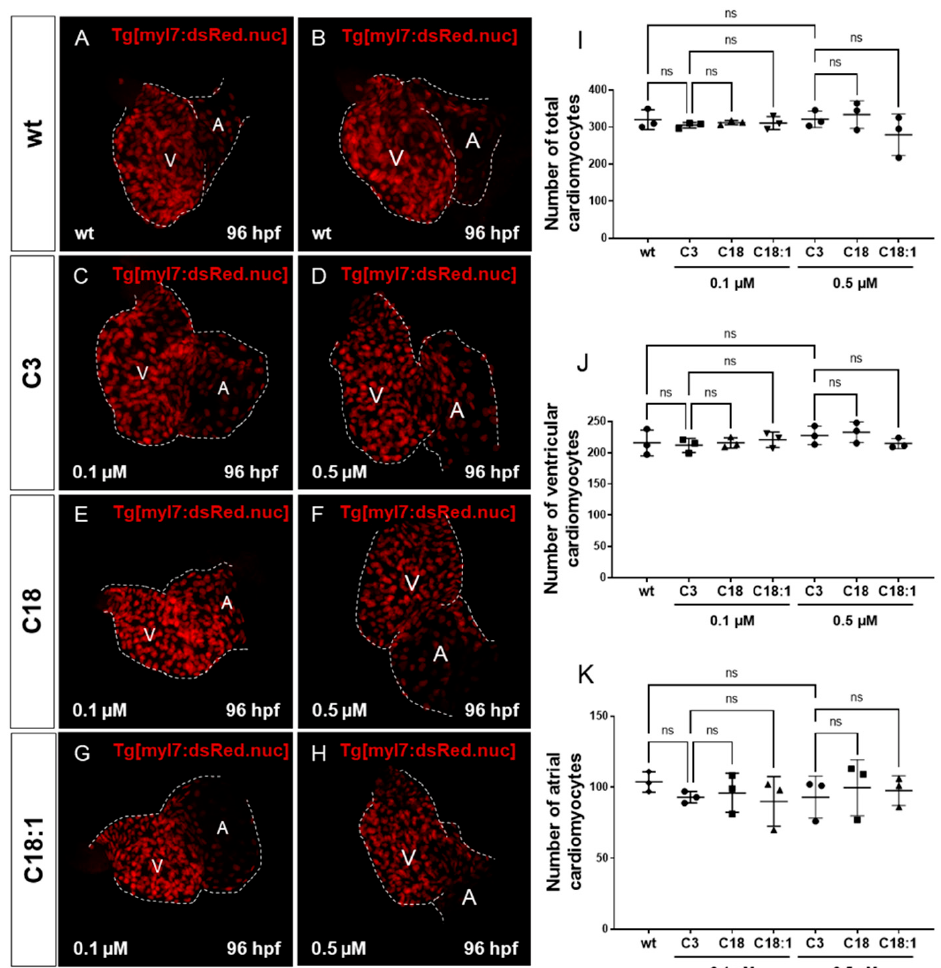
Figure 6. Impact of LCACs on cardiomyocyte numbers in zebrafish embryos. ( A – H ) Red-fluorescence-positive cardiomyocytes (CMs) of zebrafish embryos in wild-type and 0.1 M or 0.5 µ M carnitine-treated embryos. ( I – K ) Counting CMs of whole heart, ventricle and atrium from wt and C3-, C18- and C18:1-treated embryos (total CMs: wt: 319.33 ± 26.08, C3 0.1 µ M: 304.67 ± 7.57, C18 0.1 µ M: 311.67 ± 5.51, C18:1 0.1 µ M: 310.67 ± 17.56, C3 0.5 µ M: 320.67 ± 21.78, C18 0.5 µ M: 333.33 ± 37.17, C18:1 0.5 µ M: 279.0 ± 55.75, SD, n = 3, ns: p > 0.05; ventricular CMs: wt: 215.67 ± 20.74, C3 0.1 µ